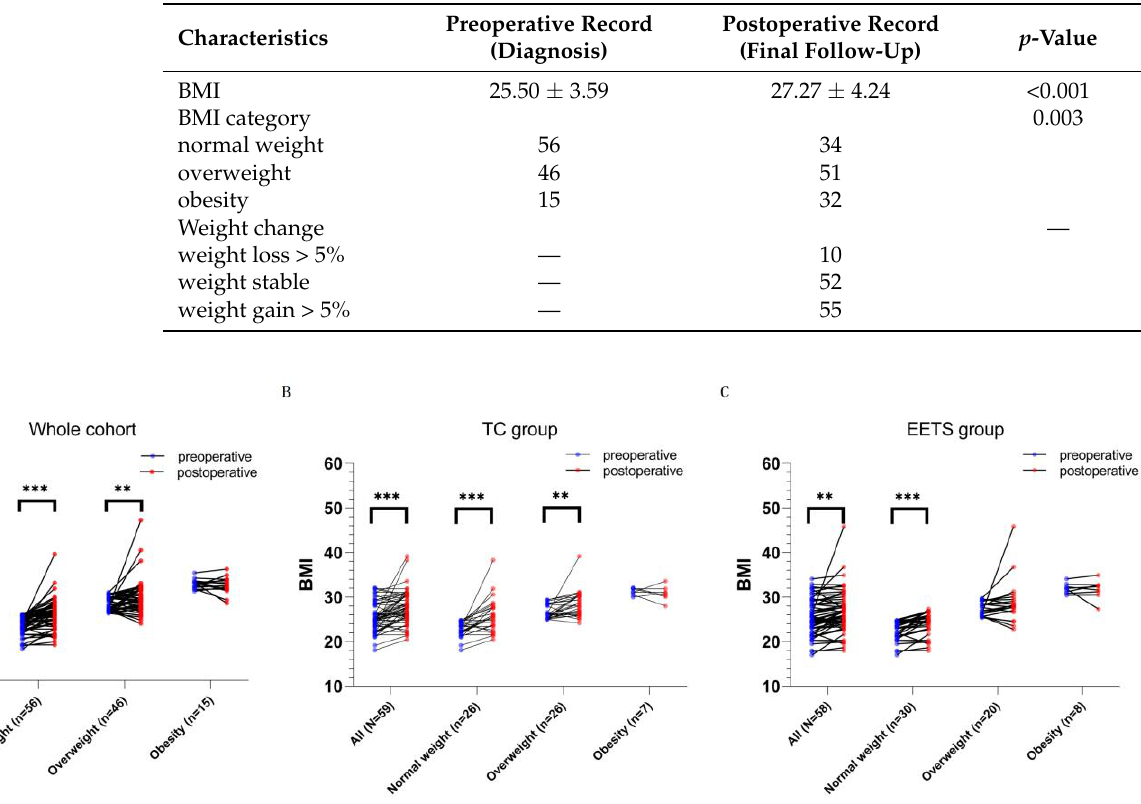
Figure 4. The preoperative and postoperative BMI based on the preoperative BMI category in the adult-onset craniopharyngioma cohort. ( A ) The difference between preoperative BMI and postop- erative BMI in the whole cohort. ( B ) The difference between preoperative BMI and postoperative BMI in the TC subgroup. ( C ) The difference between preoperative BMI and postoperative BMI in the EETS subgroup. Compared to the TC group, the EETS group yielded similar impacts of the operation on weight change in patients with normal preoperative weight or preoperative obesity, except